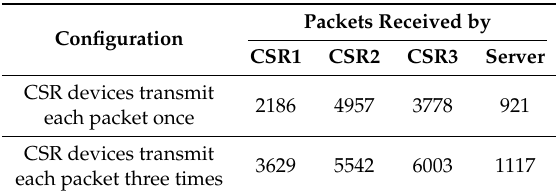
Table 4. Packets received by CSR devices and BLE server in CSR Mesh evaluation, for each CSR device configuration.